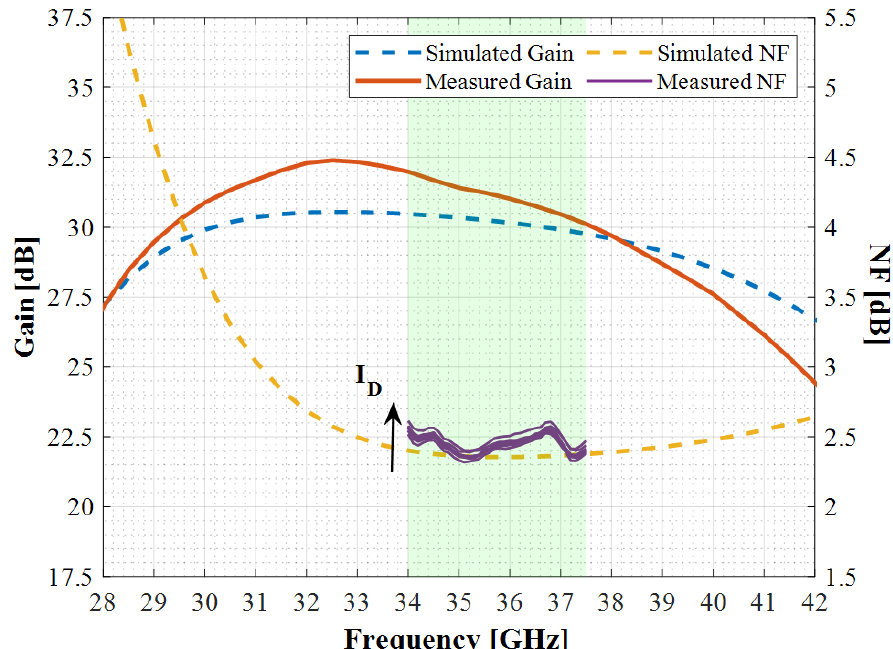
Figure 8. Gain and NF of the designed LNA. Dashed lines represent simulations, while continuous lines depict measurements. The narrowband purple traces represent the NFs of two different LNA cells measured at different I D values.